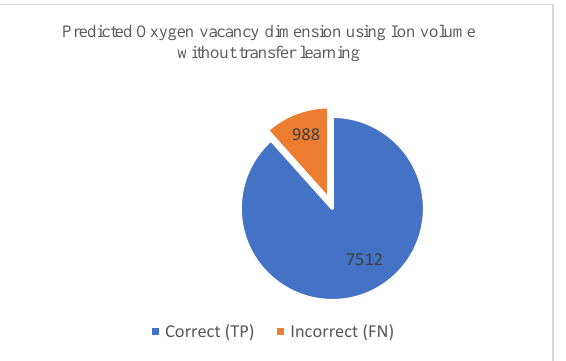
Figure 7. Predicted oxygen vacancy dimension using Ion volume without transfer learning.